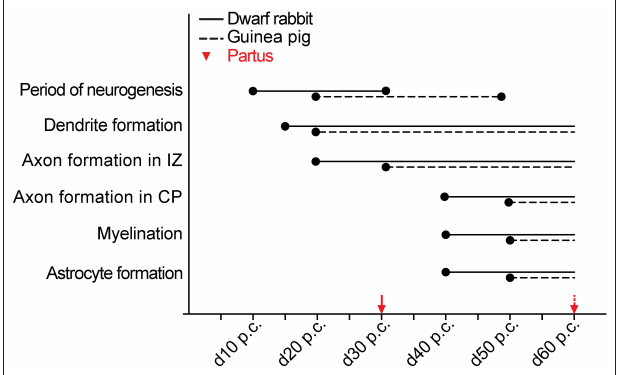
FIGURE 12 | Comparison of specific neurodevelopmental events between the dwarf rabbit and guinea pig neocortex. Onset and duration of the period of neurogenesis, dendrite formation, axon formation, myelination, and astrocyte formation in the dwarf rabbit and guinea pig neocortex between day 10 and 60 post-conception (p.c.). Data for the period of neurogenesis are based on the development of Tbr2 + NPCs in the SVZ ( Figure 4 ); data for dendrite formation, axon formation, myelination, and astrocyte formation are based on immunofluorescence staining ( Figures 6 – 11 ). For details, see the Results section. Data for dwarf rabbits are shown in solid black lines, data for guinea pigs are shown in black dashed lines. Red arrows indicate the respective time of birth (partus) of the dwarf rabbit (solid line) and guinea pig (dashed line). IZ, intermediate zone. CP, cortical